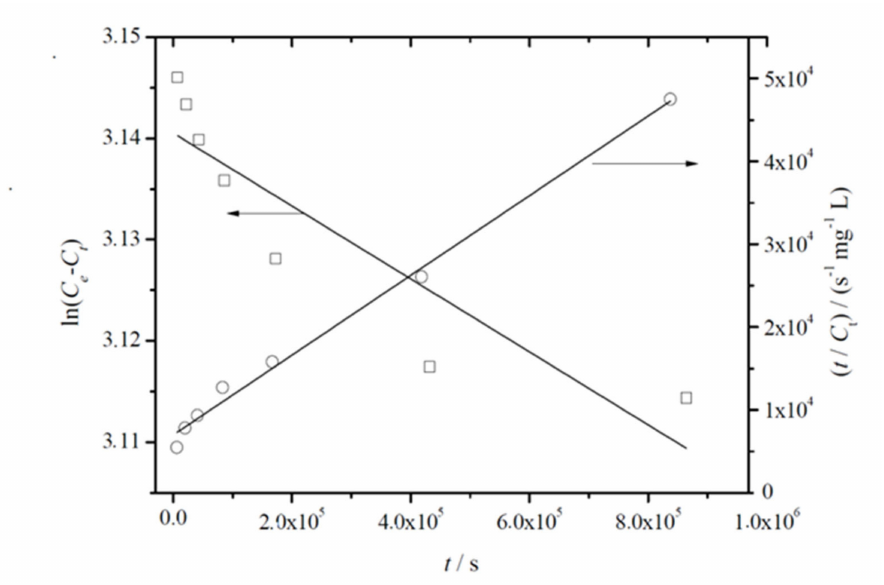
Figure 4. Representative plot of the fitting of linearized forms of pseudo-first (left y y -axis, white squares, Equation (5)) and pseudo-second (right y y -axis, white dots, Equation (6))-order equations to experimentally released amounts of thymol from PLA / T8 to ethanol 10% (v / v) at 40 ◦ C.